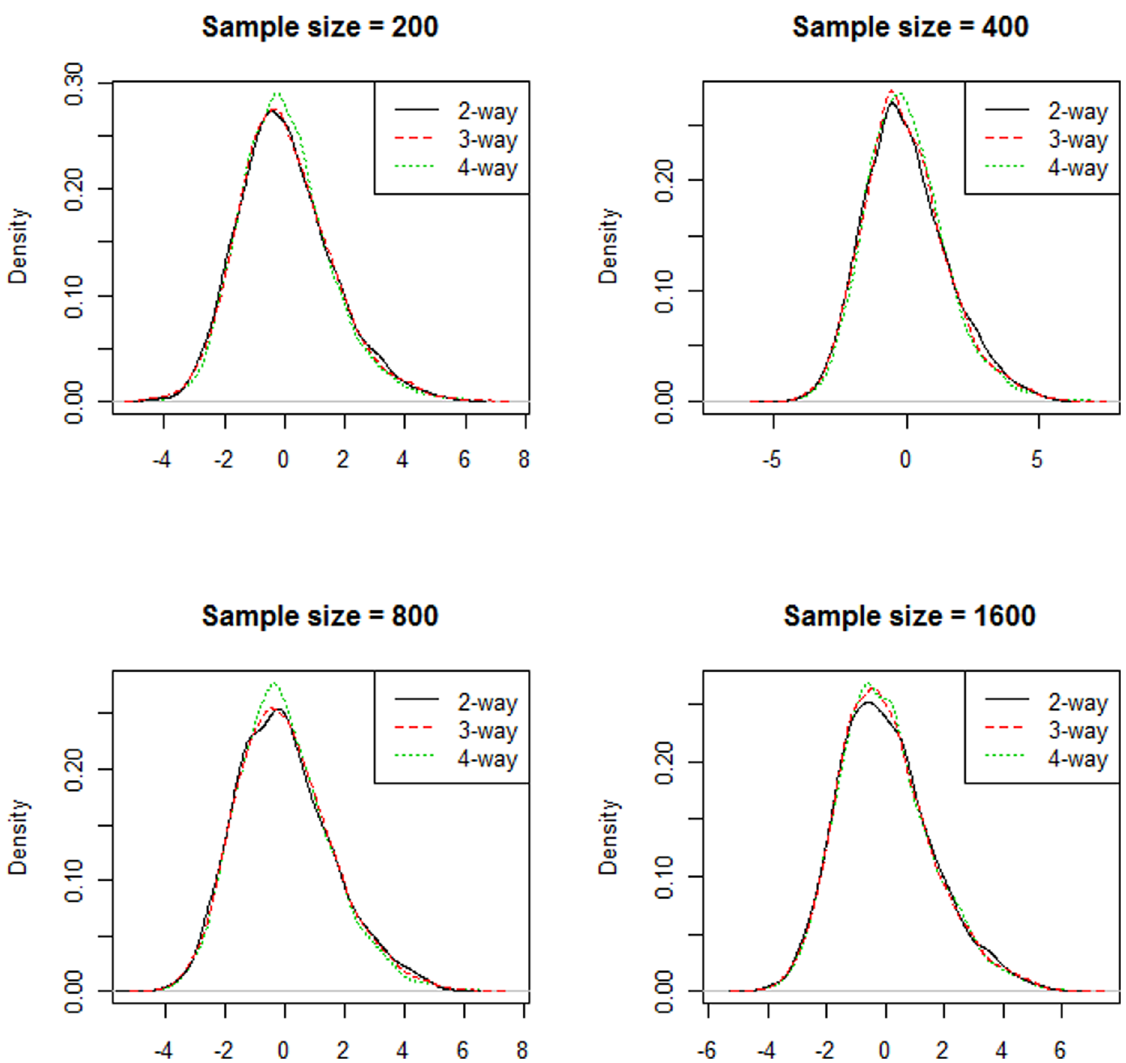
Figure 1. Empirical distribution of the 10-fold cross-validated testing score. The three curves on each figure represent the testing score from 2-way, 3-way and 4-way models.